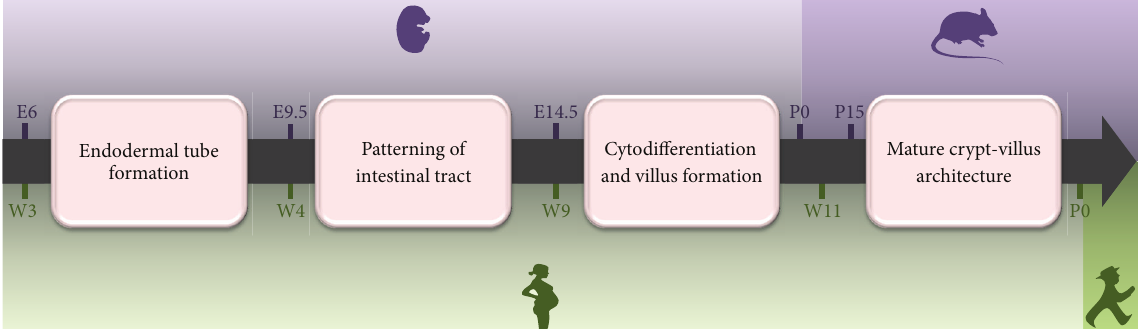
Figure 1: Time line of intestinal development in human and mice. Definitive endodermal cells are specified during gastrulation (mouse: embryonic day 6 E6, human: week 3 W3) and initiate the formation of the primitive gut tube, fully formed at E9.5 in mice and W4 in humans. At later stages, the tube is patterned along the anterior-posterior axis. Cytodifferentiation and villus formation take place from E14.5 in mouse and from W9 in human. In mice, crypt formation starts around day 15 after birth (postnatal day 15, P15), whereas in humans, mature crypt- villus architecture is already defined during fetal period from